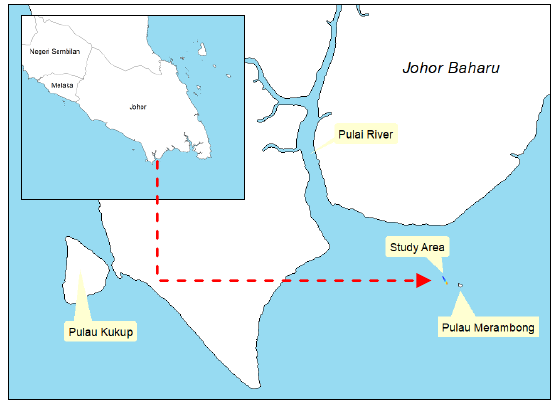
Figure 1. Location of study area.